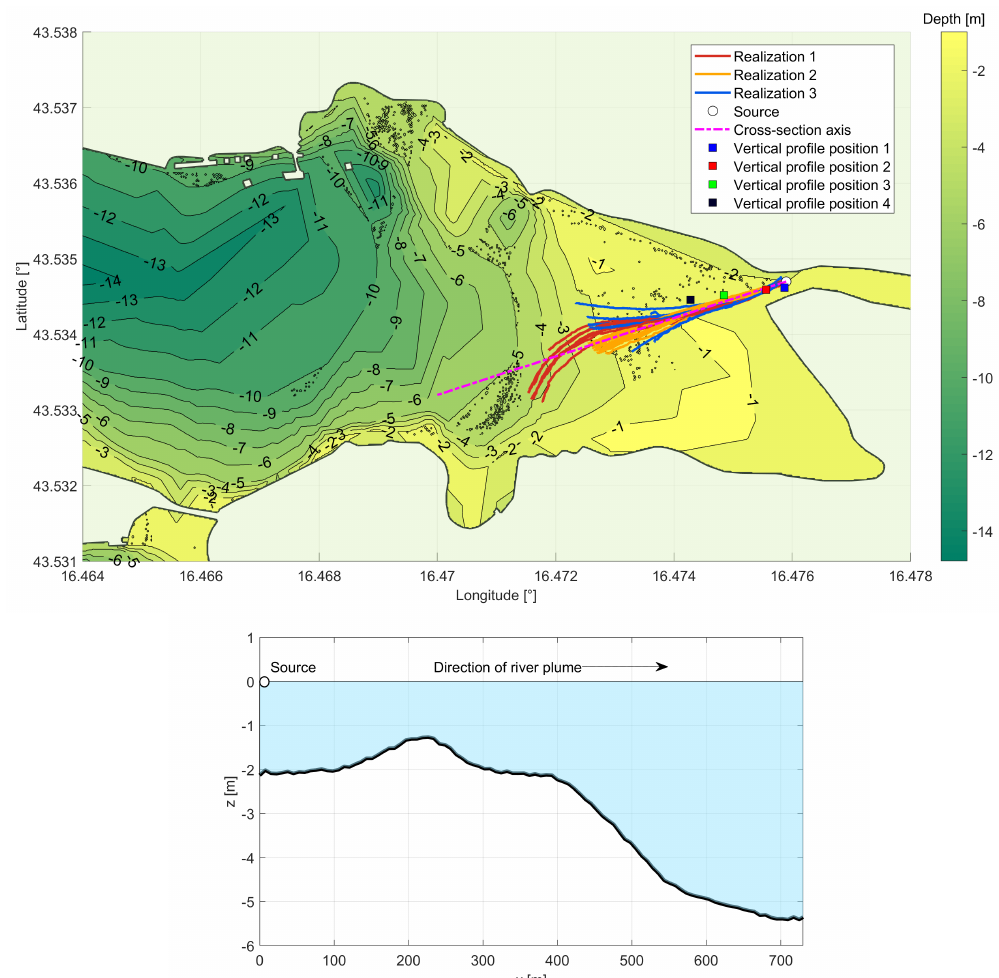
Figure 13. Planar view of the study area with annotated trajectories of probes and vertical profiles positions ( top ); and longitudinal cross section ( bottom